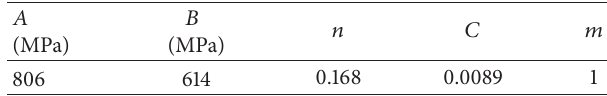
Table 2: AISI 4140 Johnson-Cook parameters.